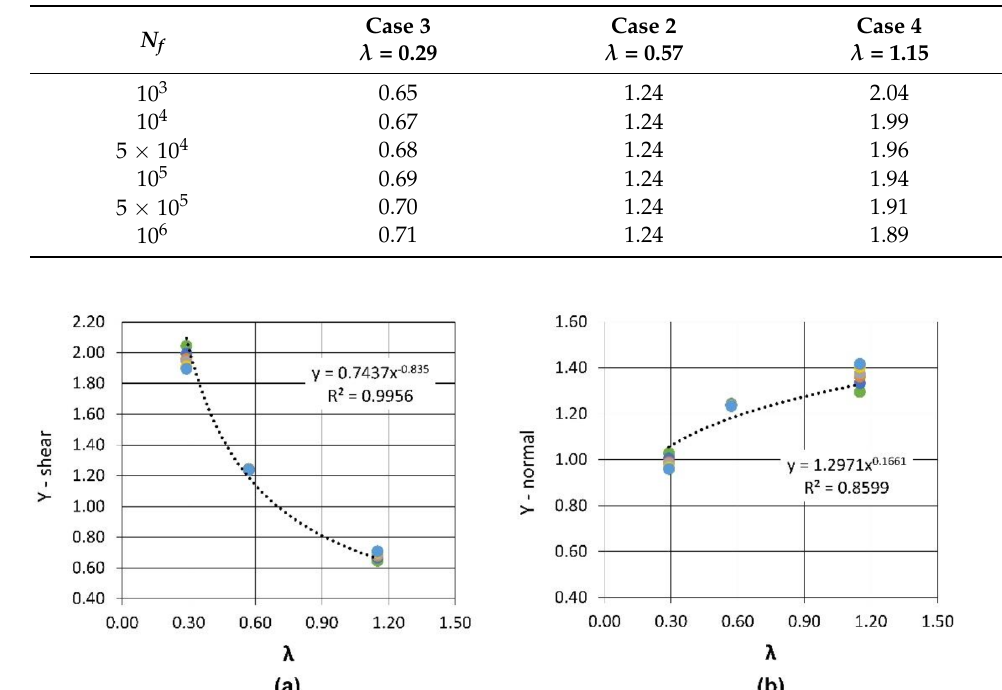
Figure 6. Y representation for loading cases 2 to 4. ( a ) variation of Y normal with λ , ( b ) variation of Y shear with λ .